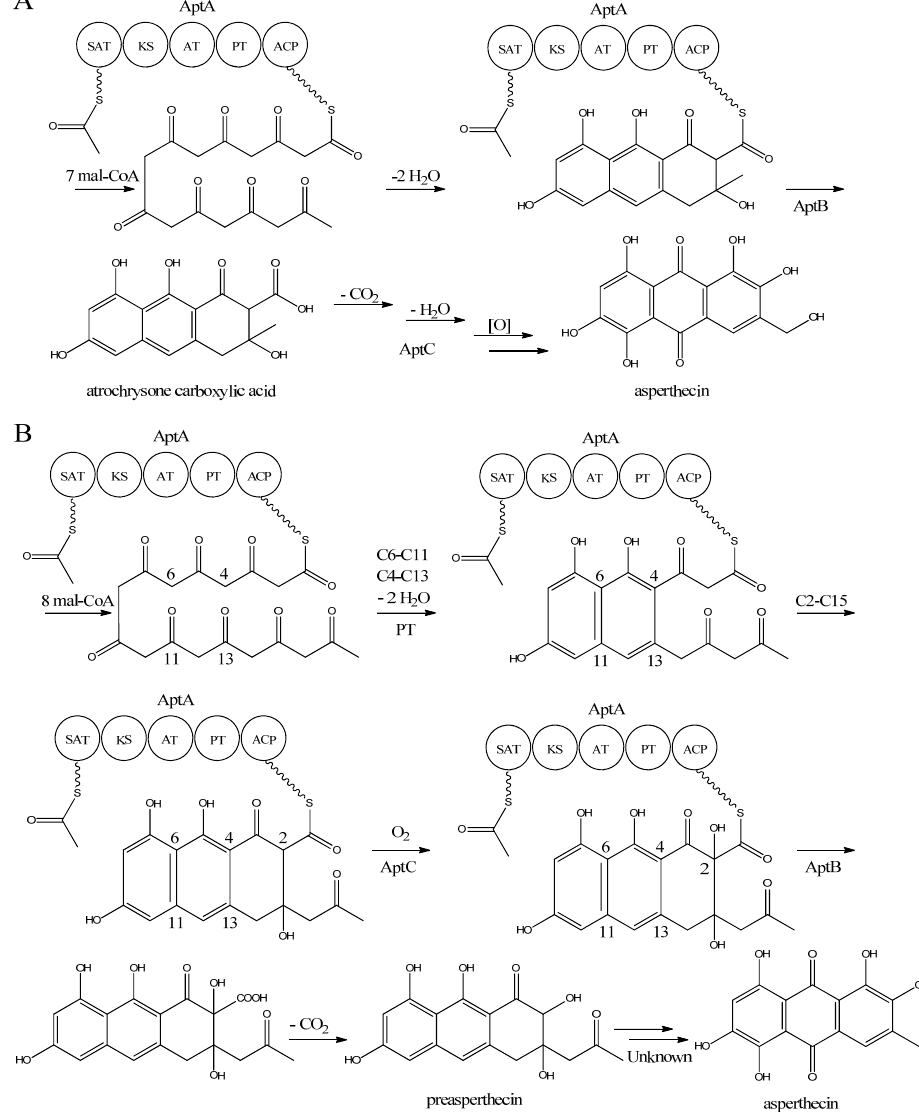
Figure 7. Proposed biosynthesis of asperthecin ( a ) As suggested by Chiang et al. [86]; ( b ) Based on proposed biosynthesis by Li et al. [87]. AptA contains SAT, KS, AT, PT and ACP domains. Multiple arrows indicate that the number of enzymatic steps is